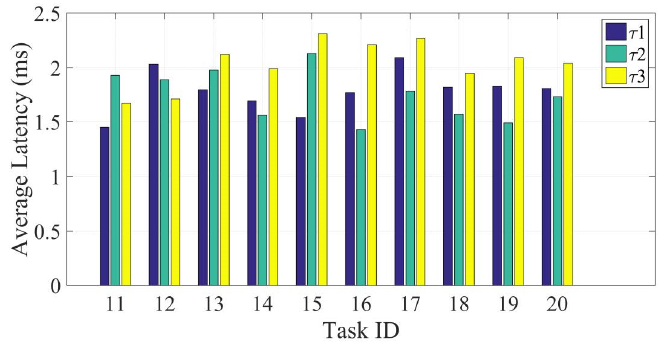
Figure 11. The average latency of handling the second group of tasks.